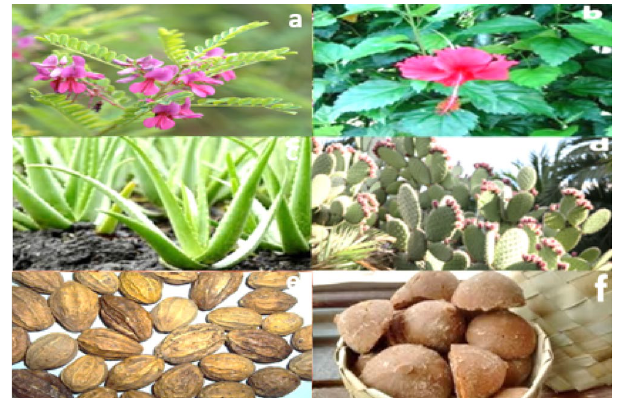
Figure 2. Seeds and plants used in Palace construction, ( a ) Neelamari plant ( b ) Hibiscus flower ( c ) Aloe vera ( d ) Cactus ( e ) Kadukkai seeds ( f ) Palm